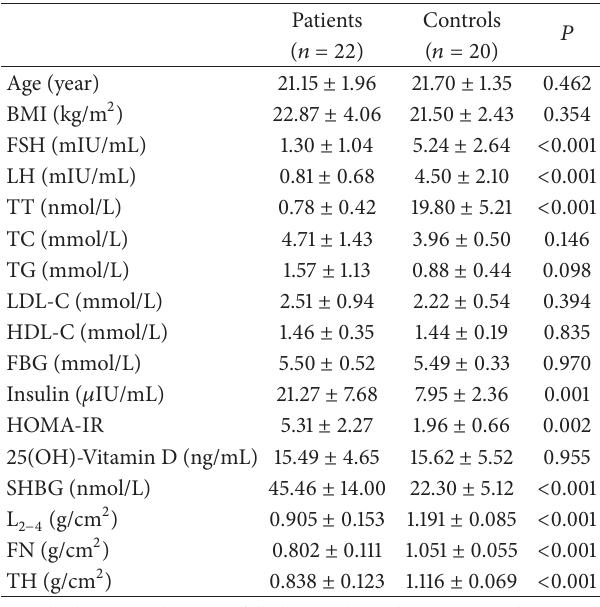
Table 1: Biochemical, hormonal, and densitometric parameters in patients and controls.